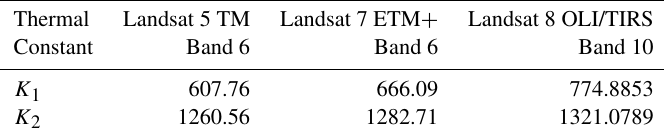
Table 1. Thermal constants applied to Landsat thermal bands for brightness temperature estimation.